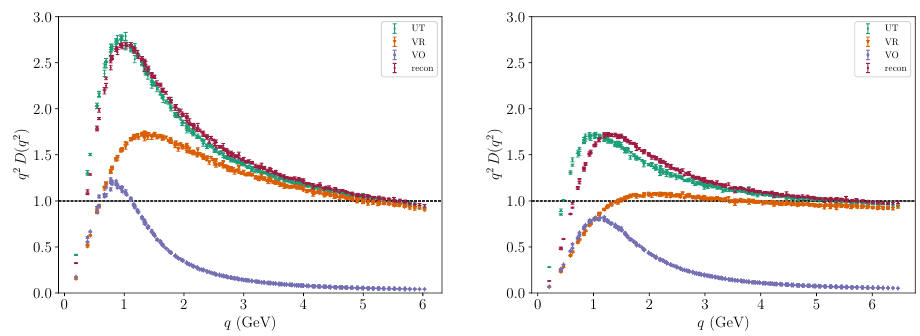
Figure 7. The pure-gauge gluon propagator (left) is compared with the m π = 156 MeV dynamical- fermion gluon propagator (right). The propagators are renormalised as described in the text. UT refers to the original untouched configurations, VR to the vortex-removed configurations and VO to the vortex- only configurations. The “recon” results are a reconstruction of the original propagator obtained from a linear combination of the vortex-only and vortex-removed propagators.